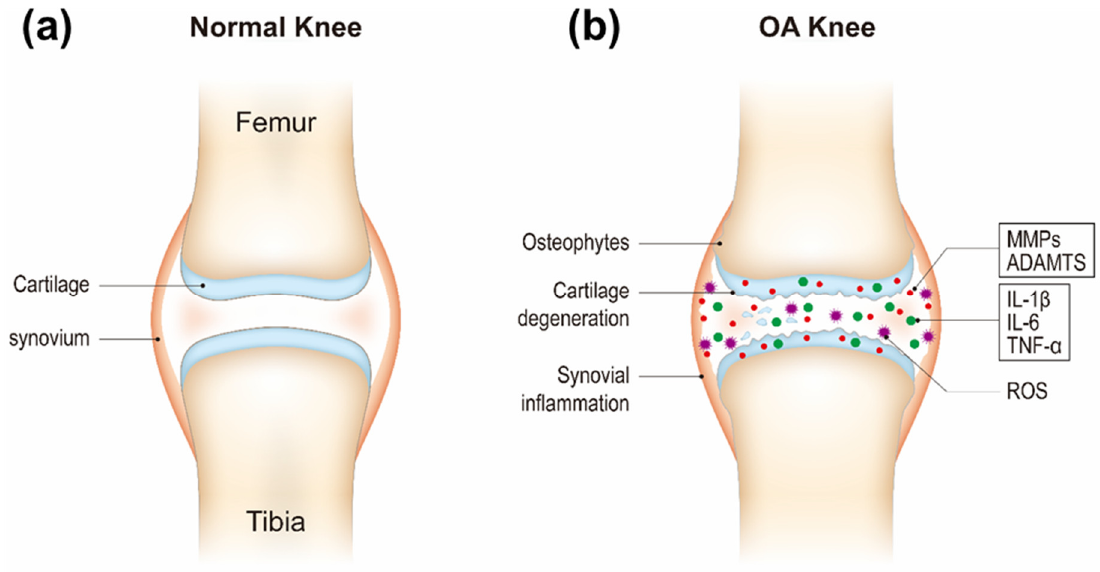
Figure 1. Schematic of healthy ( a ) and osteoarthritis (OA) knee joints ( b ).